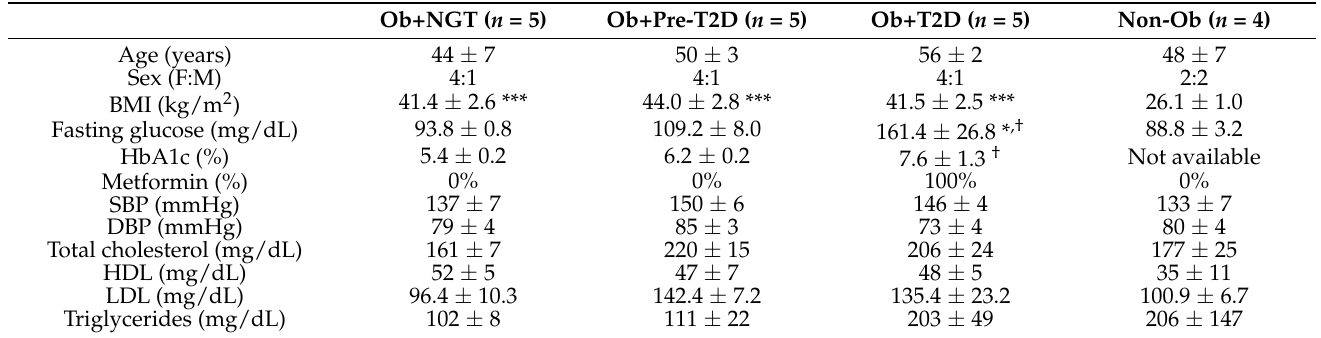
Subjects were grouped according to body mass index (BMI) and glycemic status (with obesity and euglycemia—Ob+NGT; with obesity and pre-diabetes—Ob+Pre-T2D; with obesity and T2D—Ob+T2D; without obesity—Non-Ob). HbA1c—hemoglobin A1c; SBP—systolic blood pressure; DBP—diastolic blood pressure; HDL—high-density lipoprotein; LDL—low-density lipoprotein. Data are presented as mean ± SEM. * vs. Non-Ob (*, p < 0.05; ***, p < 0.001); † vs. Ob+NGT ( † , p <